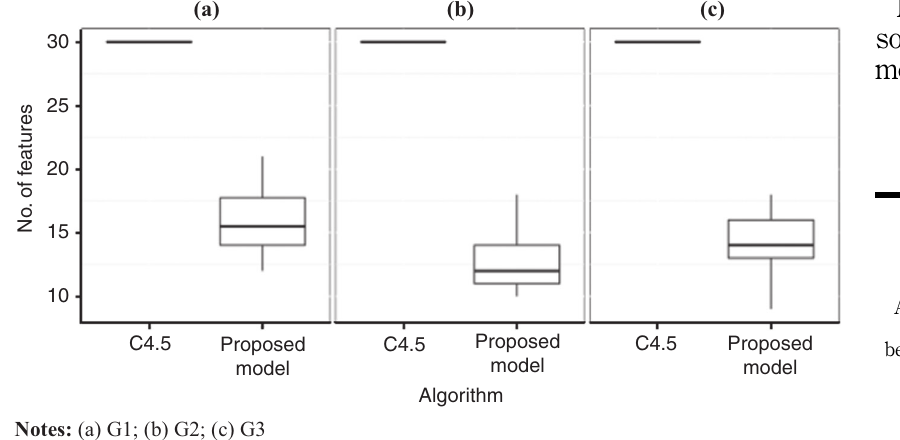
Figure 2. A comparison of the features number between the standard